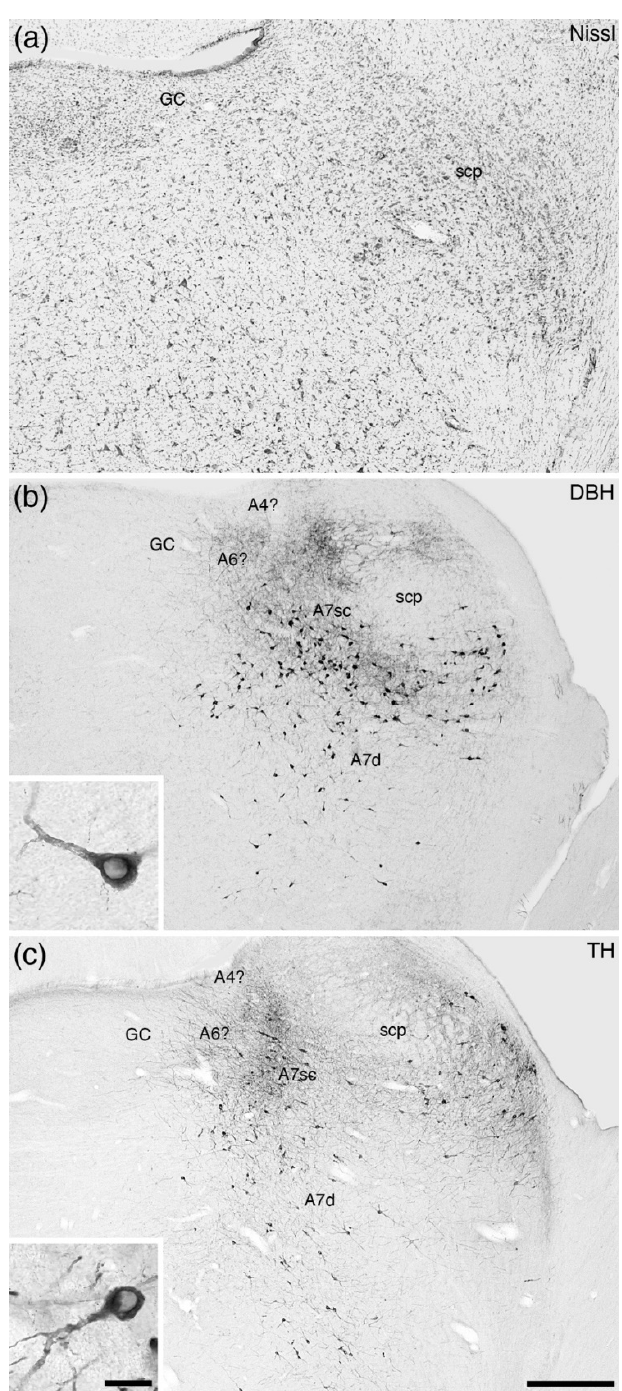
Figure 4. Low-magnification photomicrographs of the subcoeruleus of the tree pangolin [25], revealed with dopamine-β-hydroxylase ( DBH , ( b )) and tyrosine hydroxylase ( TH , ( c )) immunostaining, to compare with an adjacent Nissl-stained section ( a ). Note the presence of a larger-than-usual compact portion of the subcoeruleus ( A7sc ) and the diffuse portion of the subcoeruleus ( A7d ). No apparent dorsolateral division of the locus coeruleus ( A4? ) or locus coeruleus proper ( A6? ) is observed within the periventricular grey matter of the rostral hindbrain ( GC ). The tree pangolin is the only species in which the absence of a locus coeruleus, A6, has been observed [25]. Insets in ( b , c ) show a high-magnification image of the neurons that form the A7d . In all images, dorsal is to the top and medial to the left. Scale bar in ( c ) = 500 µm and applies to all images. Scale bar in inset c = 25 µm and applies to both insets. scp —superior cerebellar peduncle.